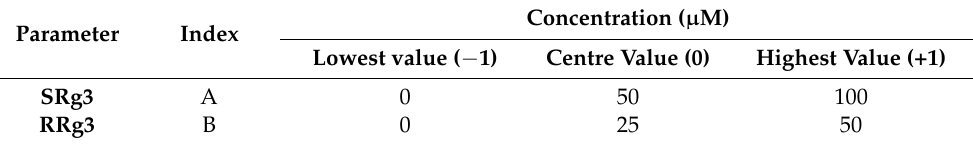
Table 1. Low, mid, and high values used for response surface methodology (RSM) model.